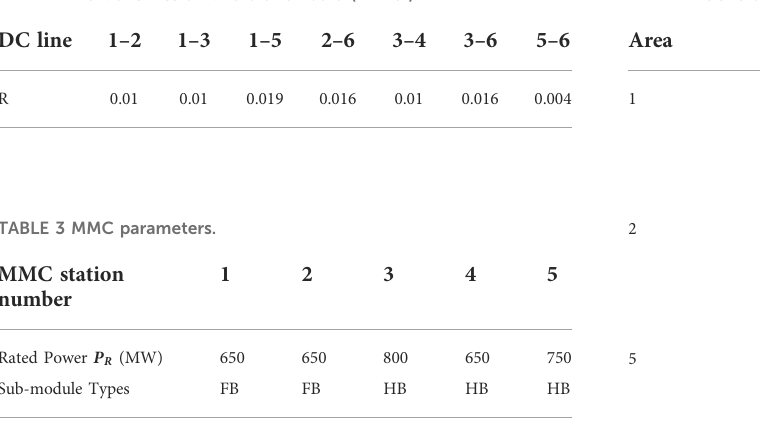
TABLE 2 DC transmission line branch data (in P.U.).